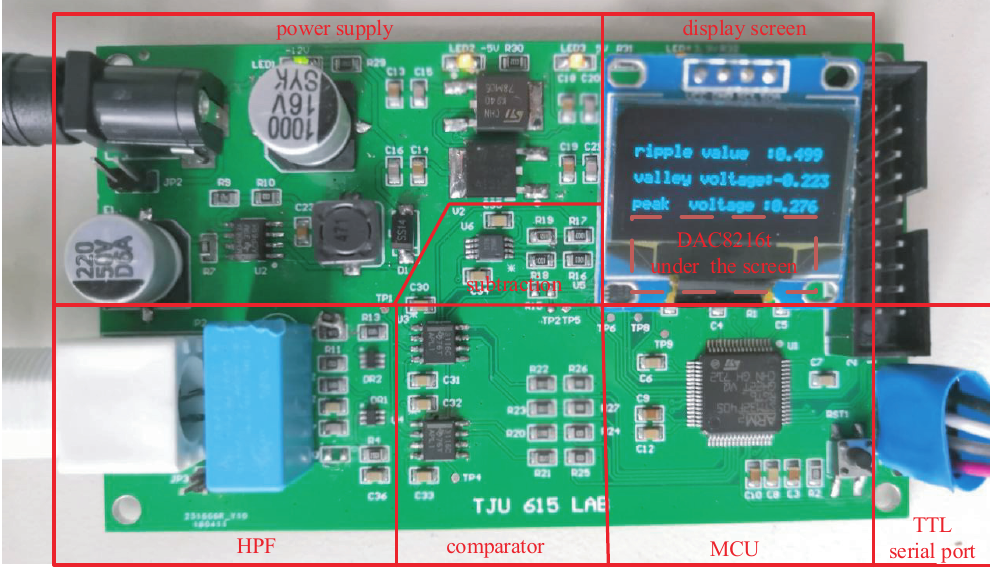
Figure 7. The prototype. Table 1. The major components of the prototype.